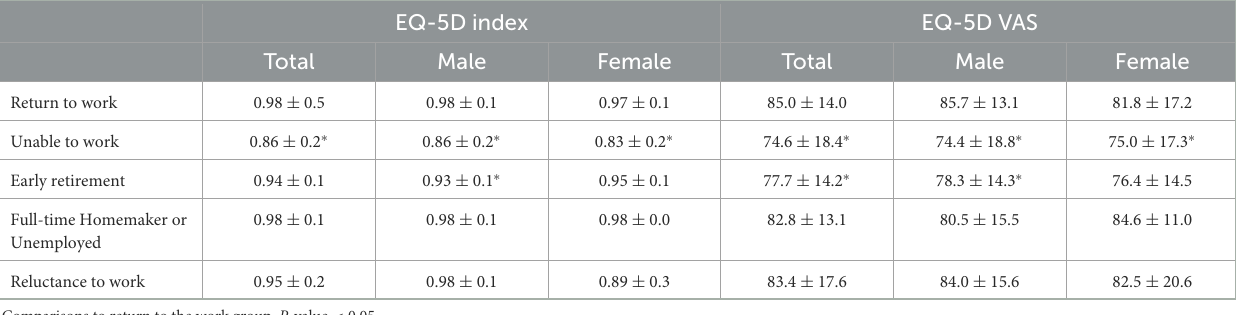
TABLE 5 Health-related quality of life across different reasons for non-RTW, stratified by gender.